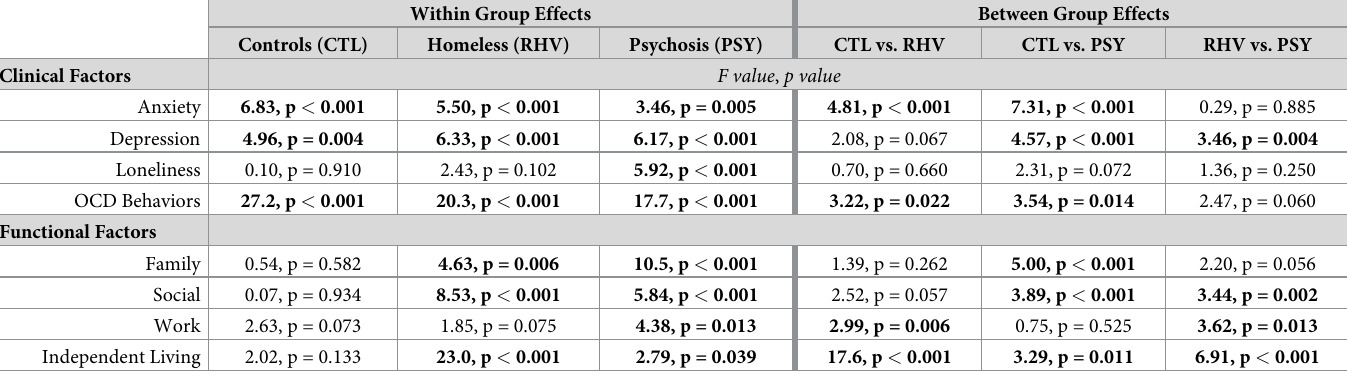
Table 2. Tests of significance and p-values derived from generalized additive models (GAM) analyses, testing for significant changes in trajectories over time for clinical and functional factors (i.e., within group effects) and for significant between-group differences in those trajectories over time (i.e., between group